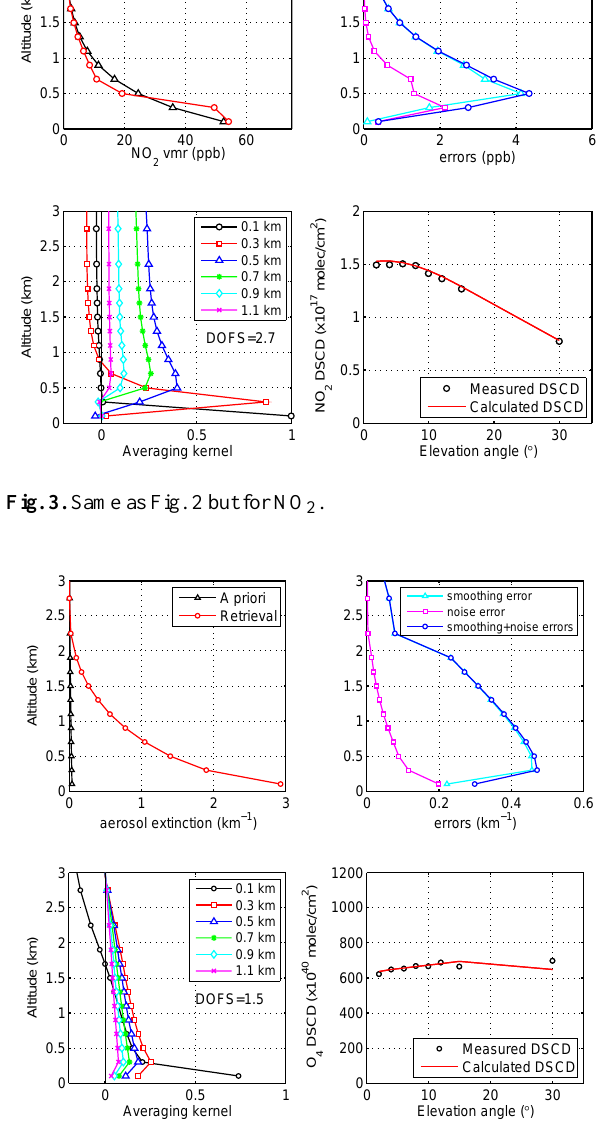
than the HONO one, leading to a significantly higher sensi- tivity of the MAX-DOAS observations to NO 2 . From the error budgets presented in Figs. 2, 3, and 4, the contribution of the smoothing error, which represents the dif- ference between the retrieved profile and the true profile due to vertical smoothing by the retrieval algorithm (Rodgers, 2000), is seen to be significantly larger than the noise (DOAS fit) error, except in the lowest layers. The sum of smoothing and noise errors on the HONO volume mixing ratio